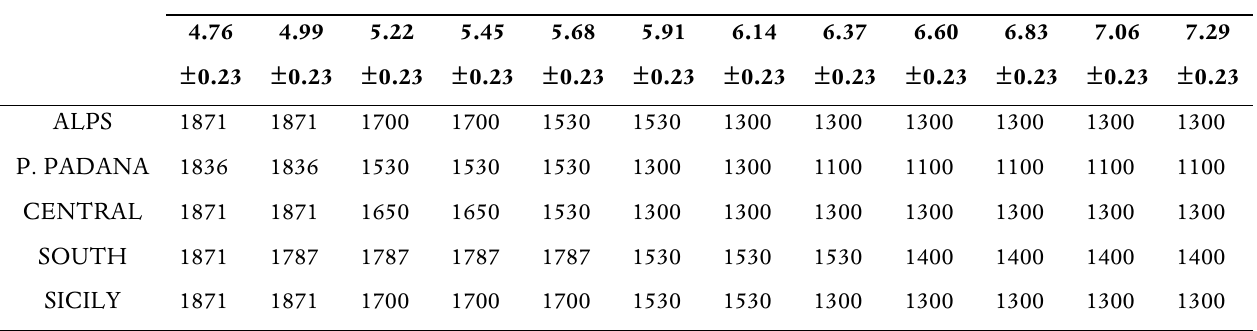
Table 1. Time completeness intervals of the CPTI04 catalog used for analysis in the Italian territory [MSP04 Working Group